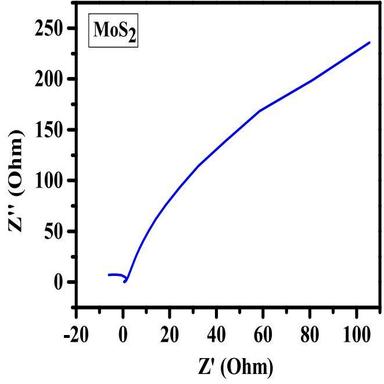
Nyquist plot of MoS2 electrode.